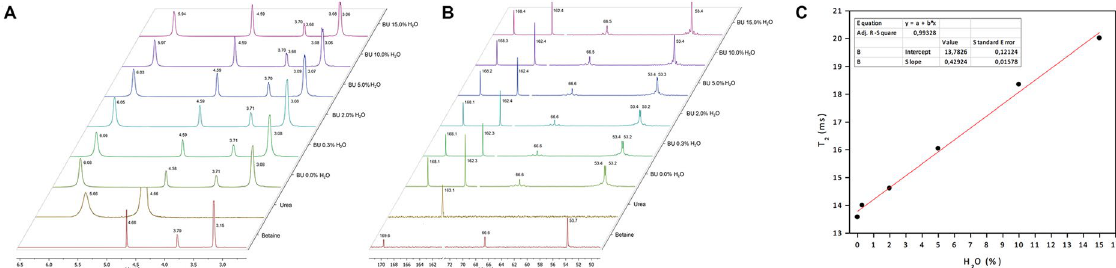
Figure 3. 1 H NMR ( A ), 13 C NMR ( B ) characterization of betaine, urea and BU prepared with different water proportion. Part C shows transversal time (T 2 ) evolution of urea proton with the variation of water content in BU. Data were obtained from three independent